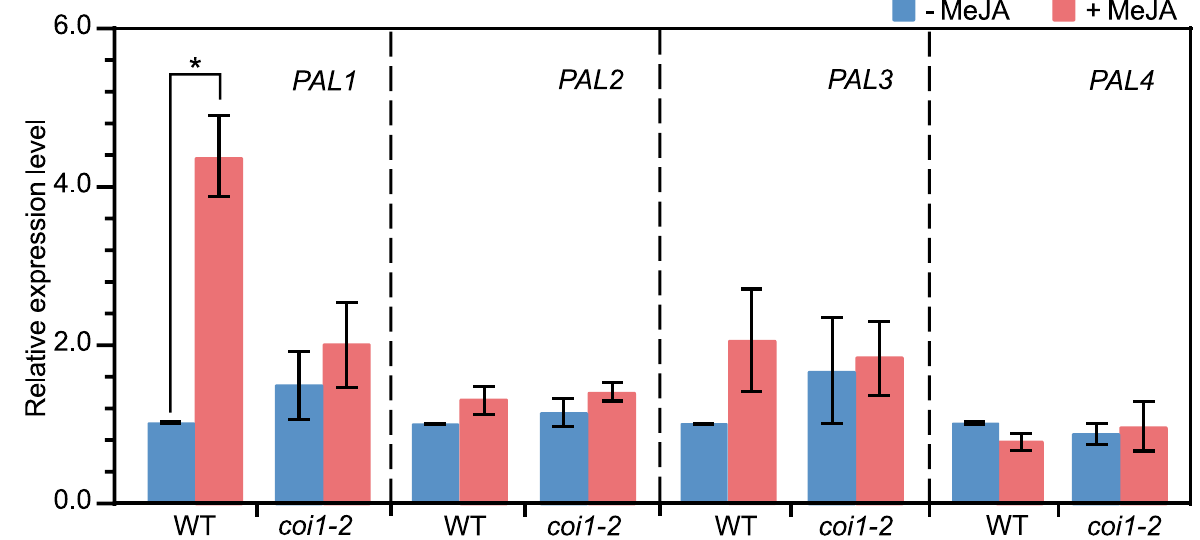
Figure 6. An analysis of expression of the PAL genes upon MeJA treatment by RT-qPCR. The relative expression levels of PAL1, PAL2, PAL3 and PAL4 in WT and coi1-2 seedlings which were first grown in medium under LD for 12 days and removed to SD for a 3-d growth, and then treated with ddH 2 O (−) or 100 μM MeJA (+) for 1 day. ACTIN2 expression was used as the internal control. Each value is the mean of three independent biological replicates ± standard deviation. An asterisk represents the significance of differences (two-tailed Student’s t-test) at the levels of P < 0.05. WT wild type, Col-0; MeJA methyl jasmonate; LD long day; SD short